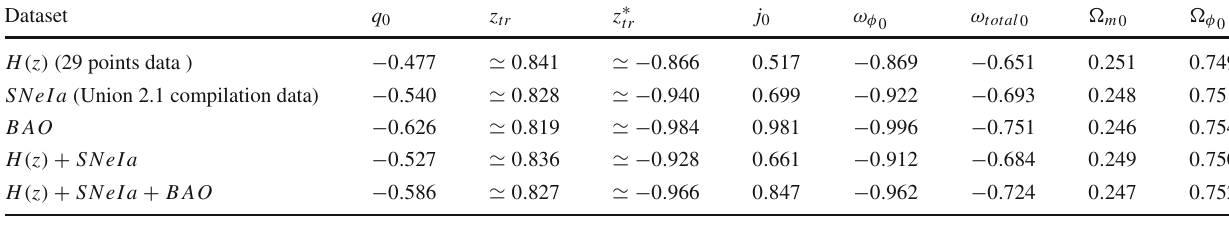
Fig. 4 a The plot of deceleration parameter q vs. redshift z . b The plot of Hubble parameter H vs. redshift z for different observational datasets